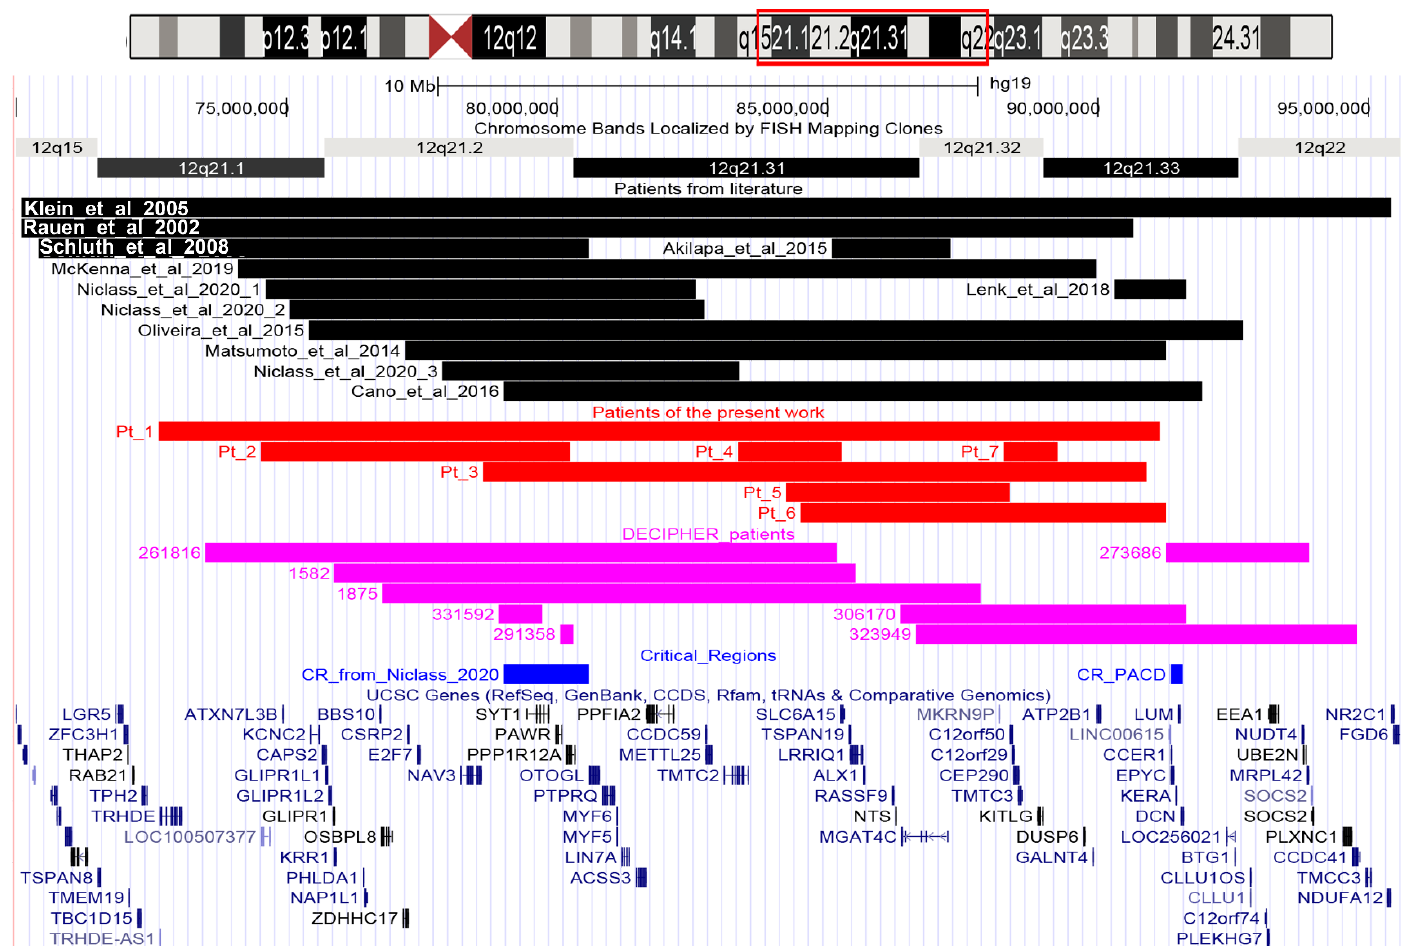
Figure 1. Physical map of the 12q15q22 region (nucleotides 70,000,000 to 95,600,000, GRCh37/hg19) adapted from UCSC Genome Browser: differently colored bars indicate the genomic regions involved in the microdeletions of our seven patients (red bars), deleted patients reported in the literature (black bars) and patients described in the DECIPHER database (purple bars). All coding genes included in this region are annotated. The critical regions (CR) described in the literature are indicated with blue bars. PACD = posterior amorphous corneal dystrophy [10].